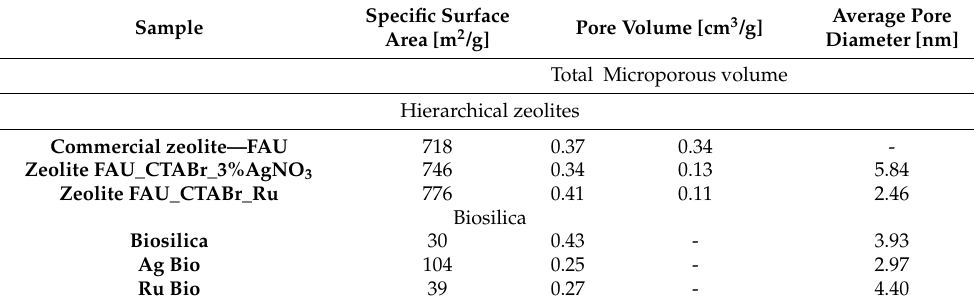
Table 1. Porous structure parameters of the materials